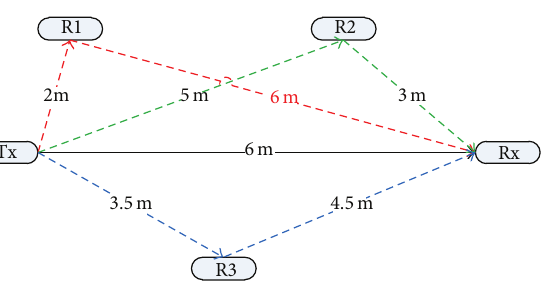
Figure 5: Relay selection example.